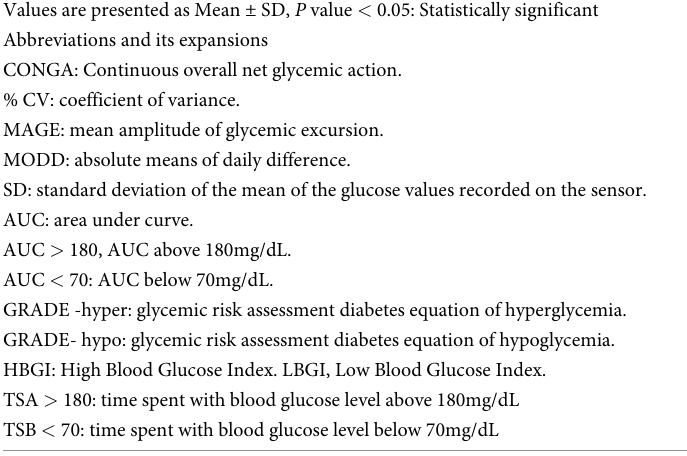
(43.62 ± 18.44ng/ml, P < 0.01). Similarly, the post prandial glucagon levels were significantly higher in the AWARE group when compared to the UNAWARE group (p < 0.01), and the controls (p: < 0.05) across all the time-points as shown in Fig 2B .